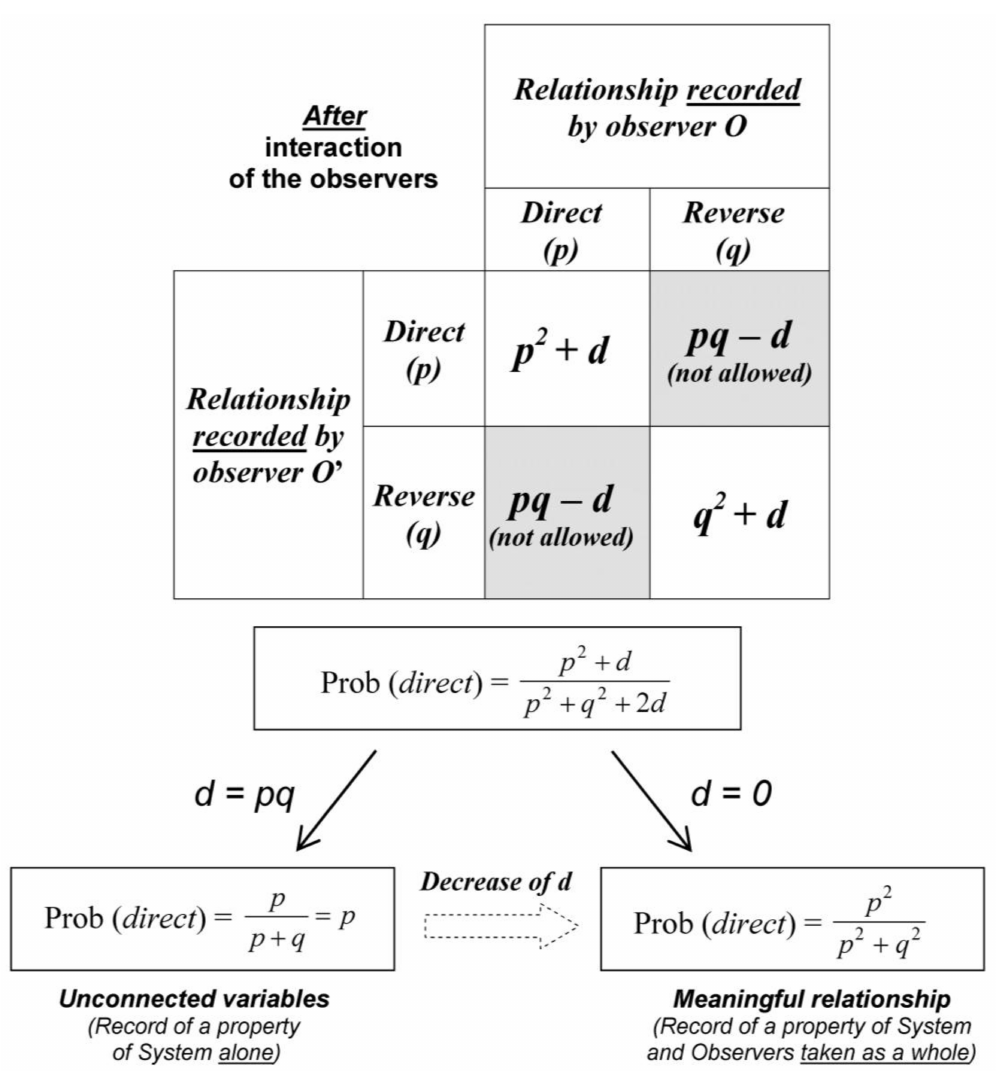
Figure 6. From perfect correlation to complete independence of observers’ expectations. The modelling is generalized in order to consider in the same equation either the record of a property of S alone or the record of a property of O - S and O ’- S (taken as a whole). Thus, the variation of the parameter d from 0 to pq allows a progressive shift from unconnected variables to a meaningful